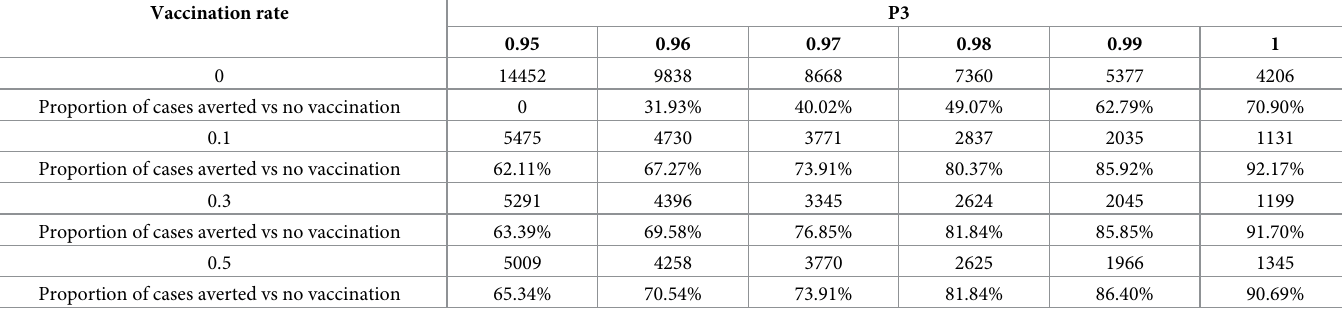
Table 5. Impact of combined interventions on cumulative Ebola cases and the proportion of cases averted versus no vaccination scenarios. Vaccination